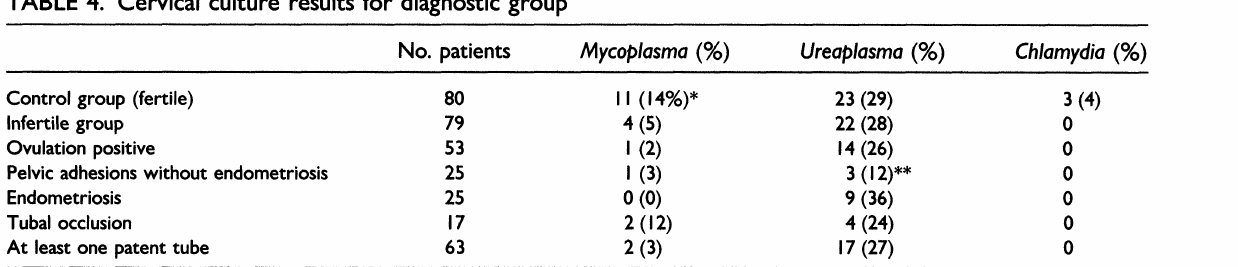
TABLE 4. Cervical culture results for diagnostic group